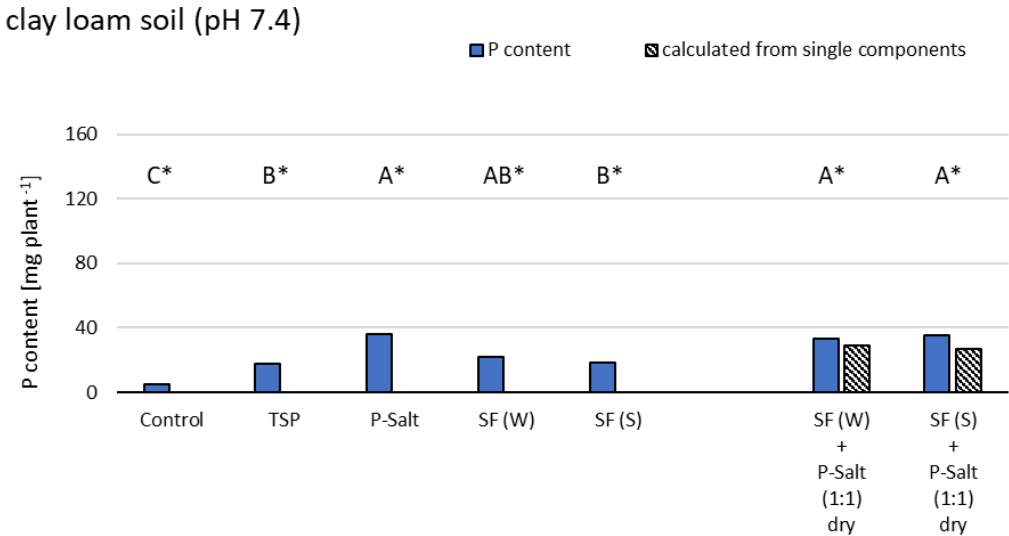
Figure 3. Total phosphorus content (P content) after 50 days in mg plant −1 of maize after soil treatment with different recycled fertilizers in a total dose equivalent to 150 mg P (kg soil) −1 ; fractions tested: P-Salt, SF(W), (SF(S), and two different combinations of them compared to unfertilized control and TSP. Based on the total fertilizer dose corresponding to 150 mg P (kg soil) −1 , designation (1:1) means that fertilizers were applied with a mass portion of SF (W or S) containing 75 mg P (kg soil) −1 plus a mass portion of P-Salt containing 75 mg P (kg soil) −1 . “Calculated P-content from single components” represent a mathematical calculation of the combinations based on the results of the real P contents of the single components (P-Salt, SF(W), SF(S)) to indicate possible additive or synergistic effects (see Material And Methods: Evaluation of Synergistic Effects, Equation (1)). Data are means of four replicates each. Different letters denote significant differences (two factorial Tukey test with p ≤ 0.05), and significant differences between the soils are indicated by an asterisk (*).